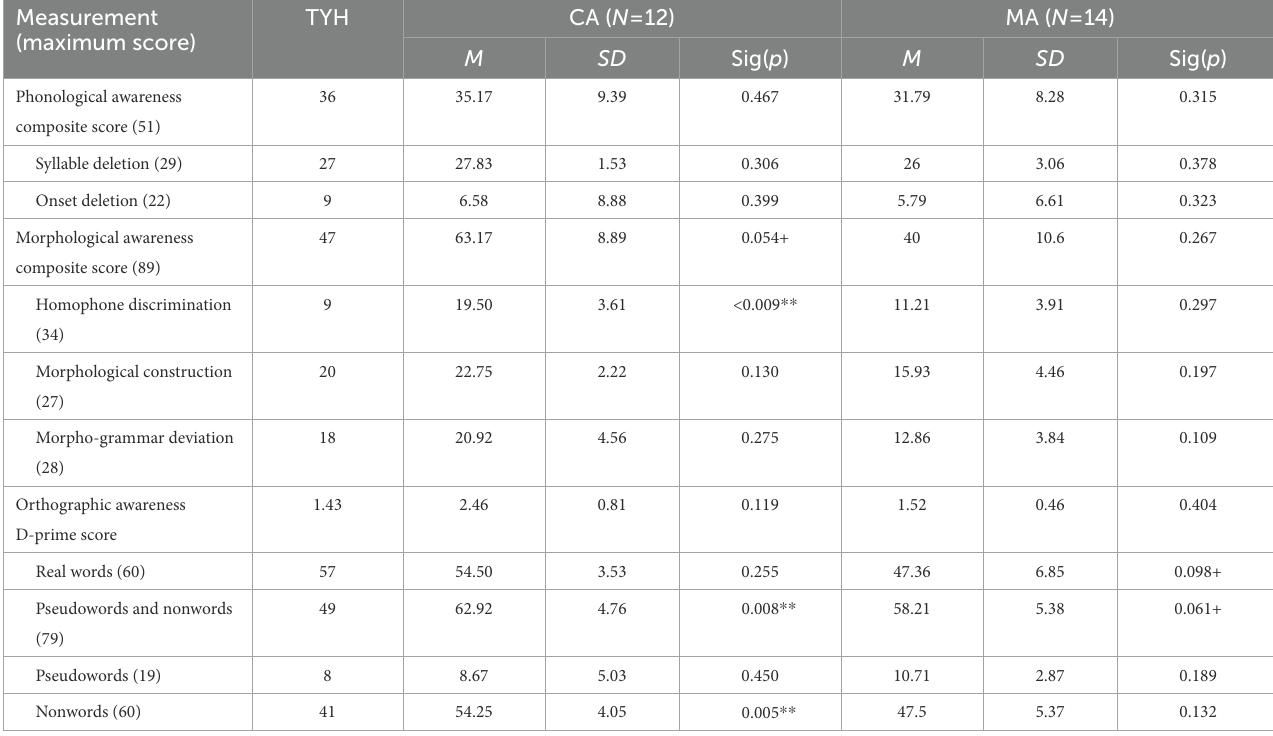
TABLE 4 Phonological, morphological, and orthographic awareness skills of participants and comparison with TYH. Measurement (maximum